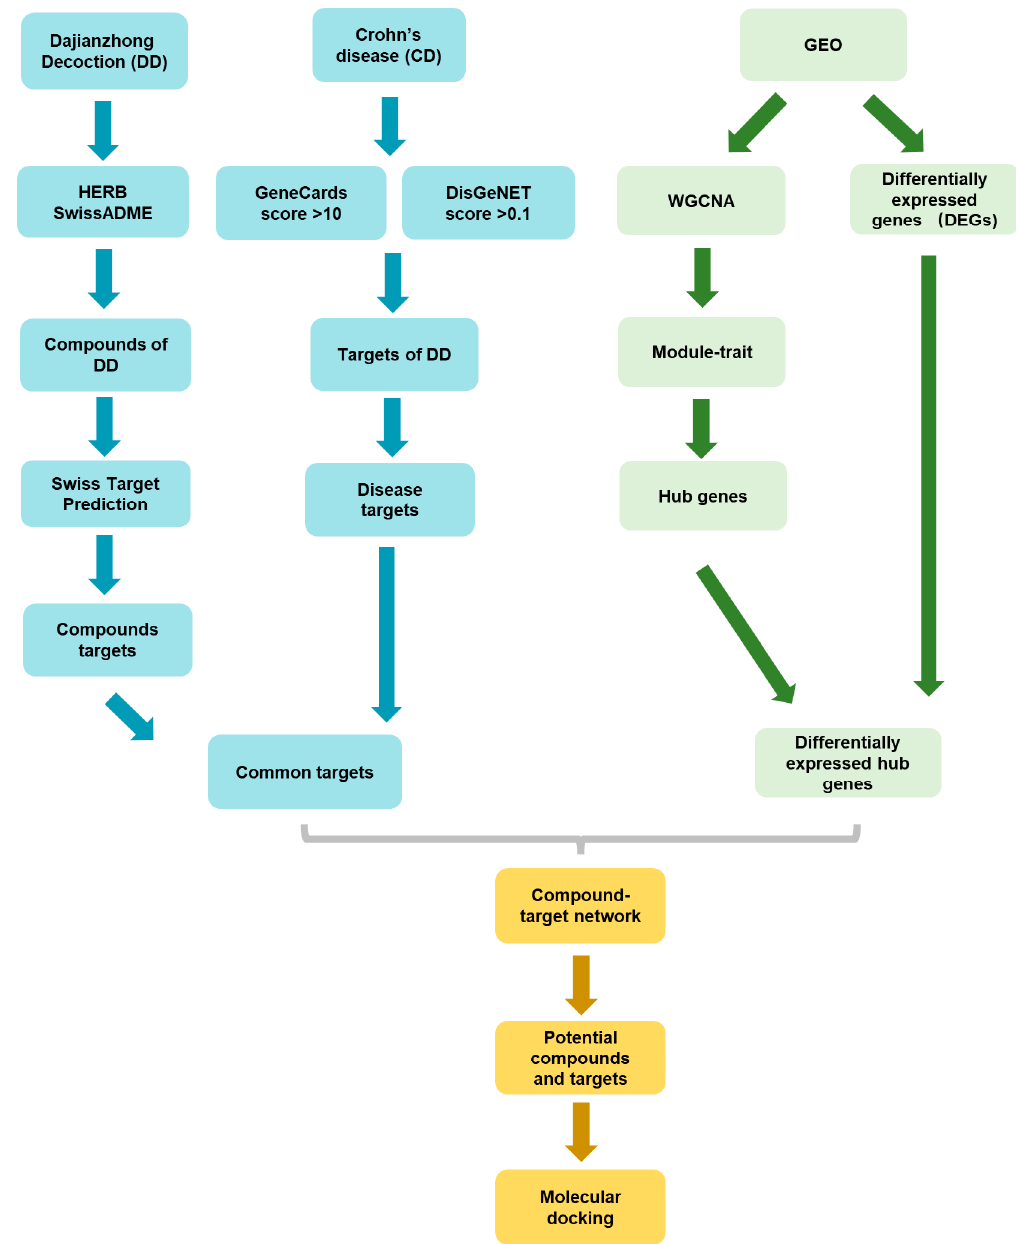
Figure 1. Flowchart of the current study’s methodology based on network analysis of